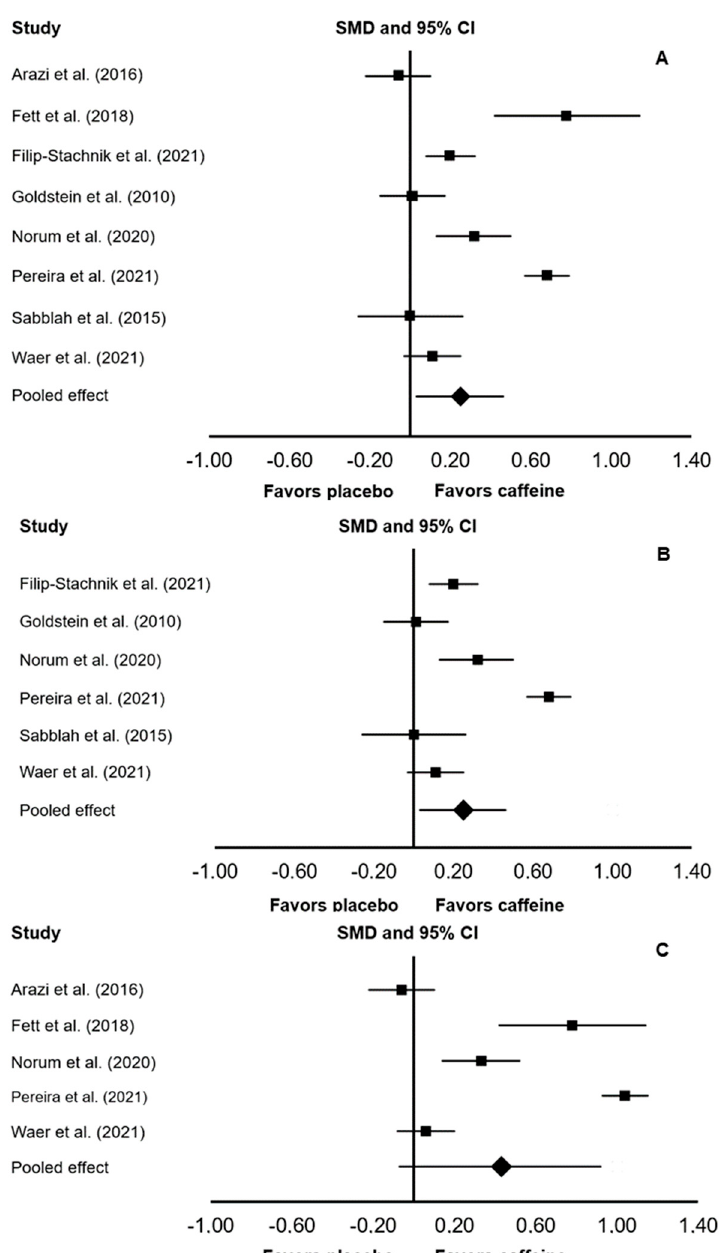
Figure 2. Forest plot presenting the results of the random-effects meta-analysis comparing the effects of placebo vs. caffeine on muscular endurance while considering all studies (A), only upper-body exercises (B), or only lower-body exercises (C). Data are reported as standardized mean differences (SMD) and 95% confidence intervals (CIs). The diamond at the bottom presents the overall effect. The plotted squares denote SMD, and the whiskers denote their 95% CIs.